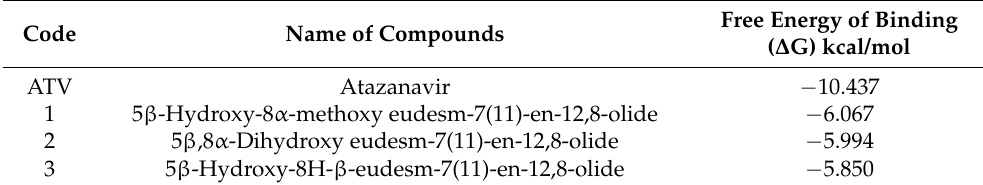
Table 4. Molecular docking analysis of against HIV-1 protease in complex with Atazanavir